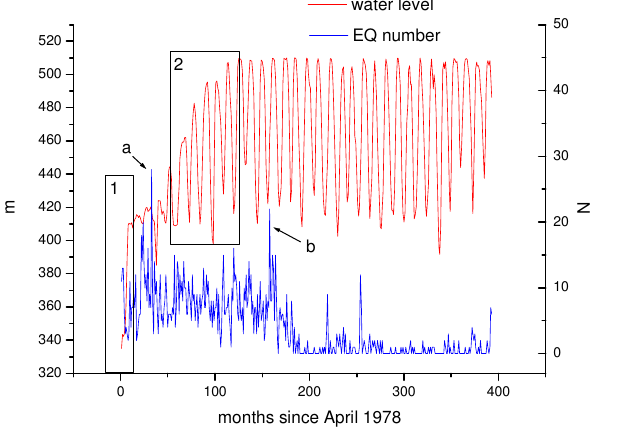
Fig. 3. Monthly number of earthquakes (blue) and monthly mean water level (red).